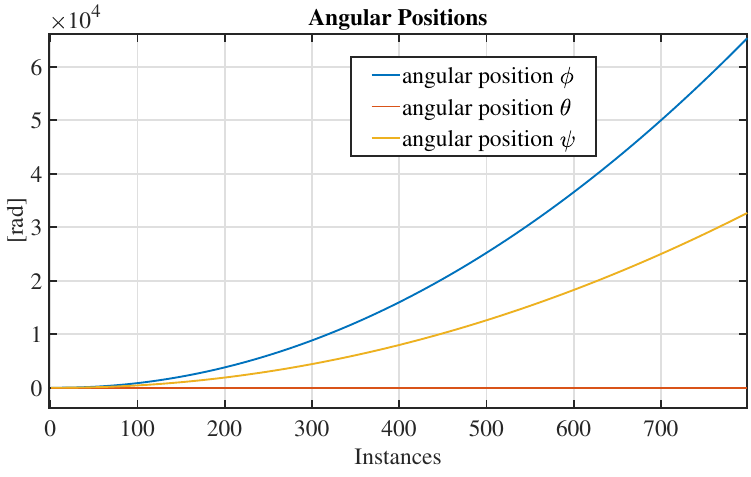
Figure 6. Angular positions φ , θ , ψ .